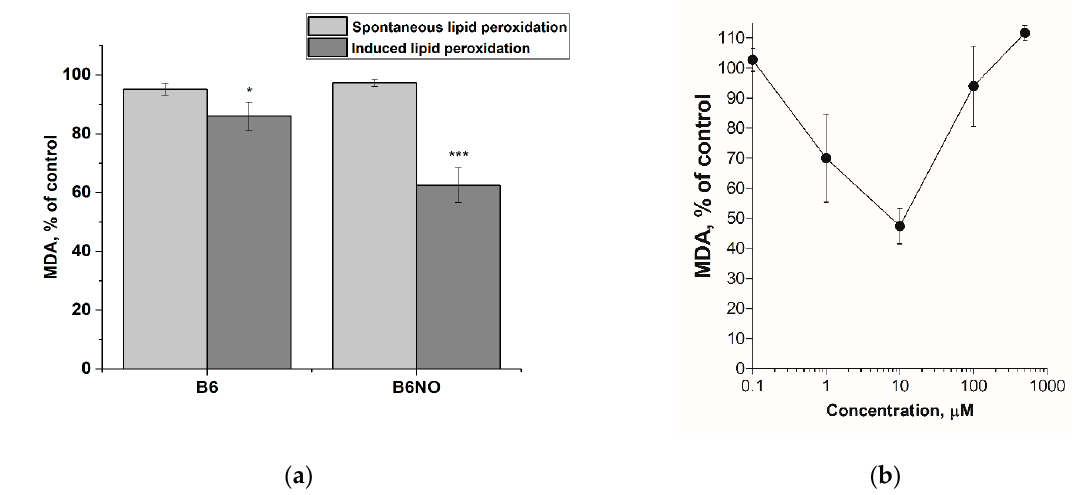
Figure 2. ( a ) Influence of hybrid molecule B6NO and vitamin B6 at a concentration of 30 μ M on the spontaneous and iron-initiated lipid peroxidation process of rat brain homogenate. The concentration of Fe(II) was 500 μ M. Significant differences are shown as * p < 0.05; *** p < 0.001. ( b ) Concentration dependence of the B6NO effect on iron-initiated lipid